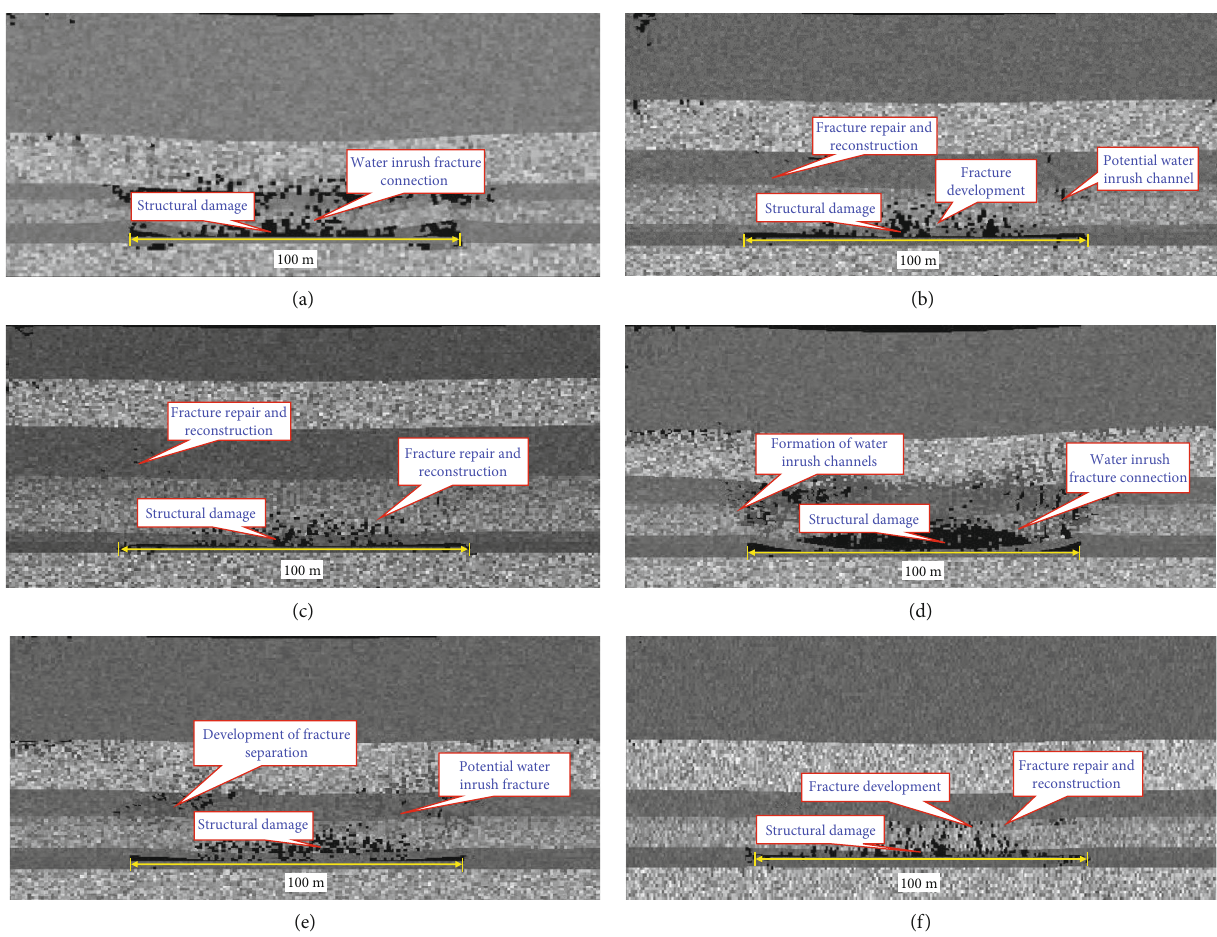
Figure 5: Fracture evolution characteristics and seepage response of overlying strata with di ff erent interlayer rock thickness and back fi lling ratios: (a) 15m; (b) 25m; (c) 35m; (d) 45%; (e) 65%; (f)